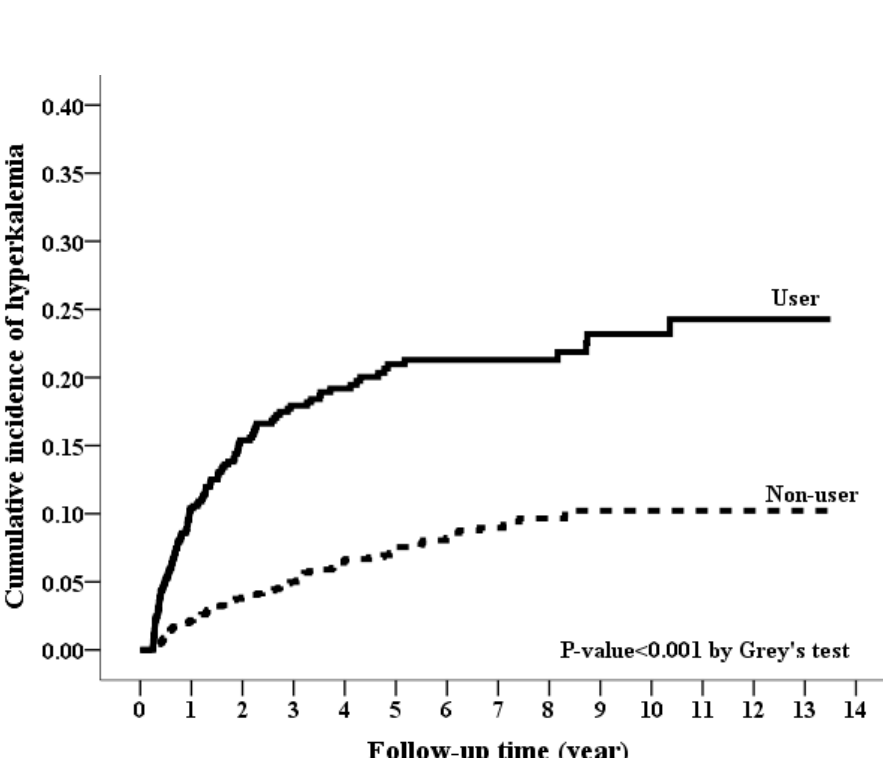
Figure 3. Cumulative incidence rate of hyperkalemia-associated hospitalization between spironolactone users and non-users. ( p -value < 0.001, Grey’s